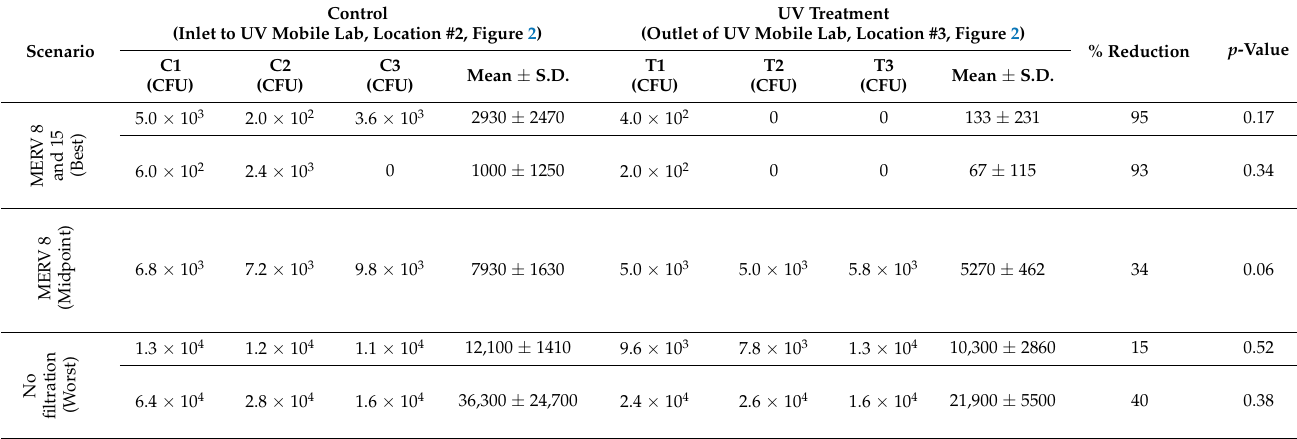
Figure 3. Schematic of particulate matter and airborne pathogens sampling ports (yellow) in the UV mobile laboratory and filtration system. Three ‐ dimensional ‘arrows’ represent free airflow. (1) Brown ‘arrow’: Exhaust air from swine barn fan; (2) Red ‘arrow’: Inlet air with reduced particle matter load after MERV filtration; (3) Blue ‘arrow’: Treated air with UV ‐ A photocatalysis.